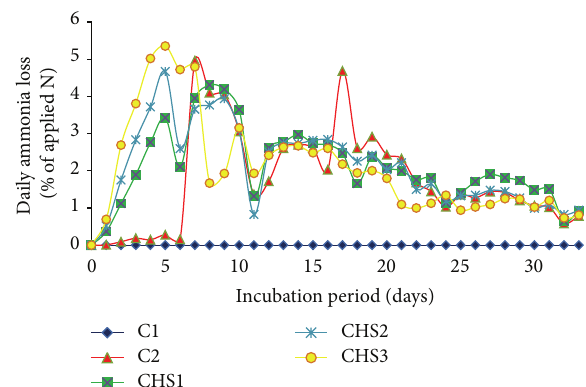
Figure1:Dailyammonialossfordifferenttreatments(C1:soilalone,